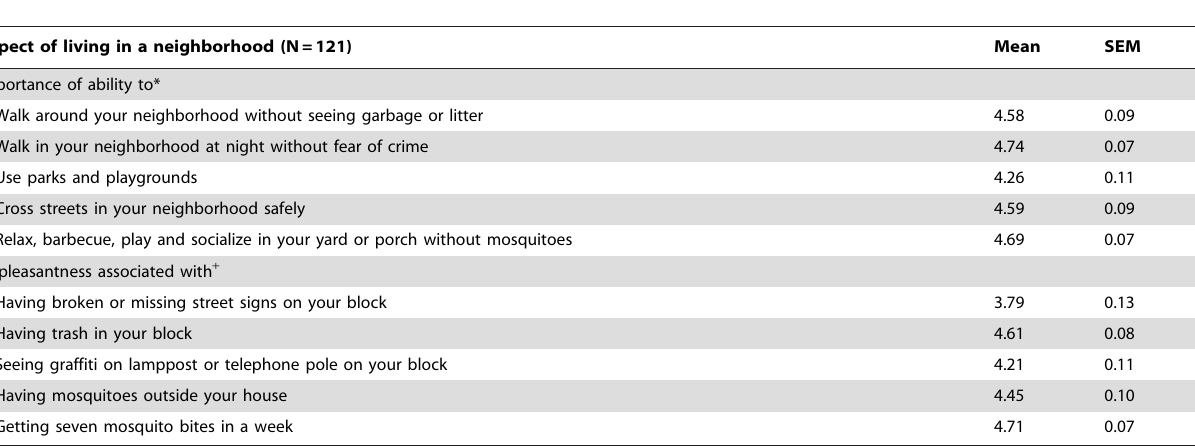
Table 2. Respondents’ perceived importance and unpleasantness of certain aspects of neighborhood, 2010.